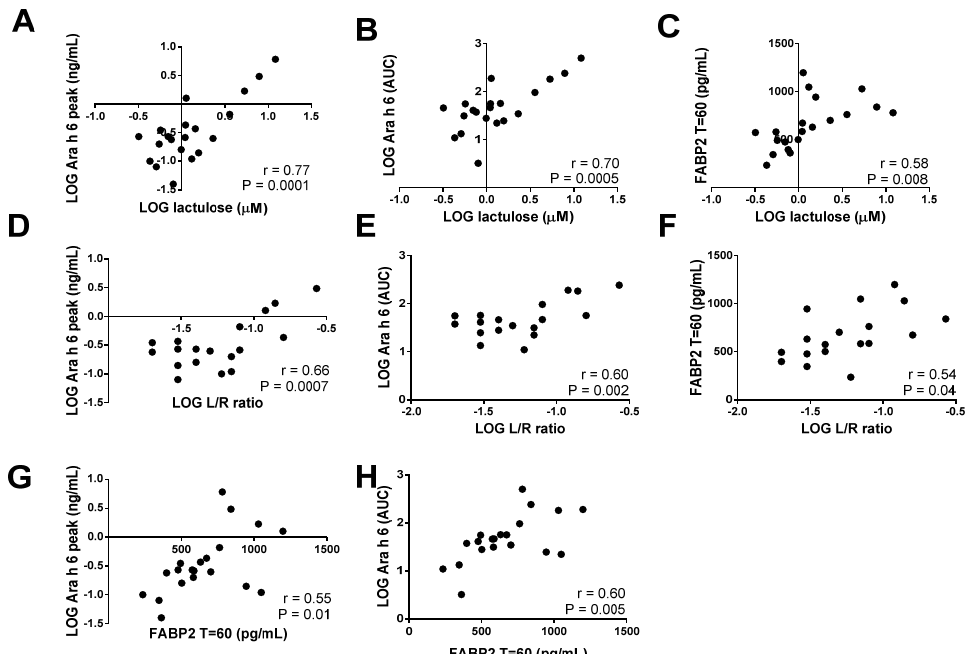
Figure 5. Correlation analysis of intestinal integrity markers and levels of Ara h 6. Correlations are shown with the calculated Pearson’s correlation coefficients ( r ) and statistical significance. Correlations are made between the lactulose levels and the peak levels of Ara h 6 ( A ) and the Ara h 6 AUC values ( B ), between the Lactulose-over- L -rhamnose (L/R) ratio and the peak levels of Ara h 6 ( D ) and the Ara h 6 area under the curve (AUC) values ( E ), and between fatty acid binding protein 2 (FABP2) levels after 60 min and lactulose levels ( C ), L/R ratio ( F ), Ara h 6 peak levels ( G ), and Ara h 6 AUC ( H ). LOG =